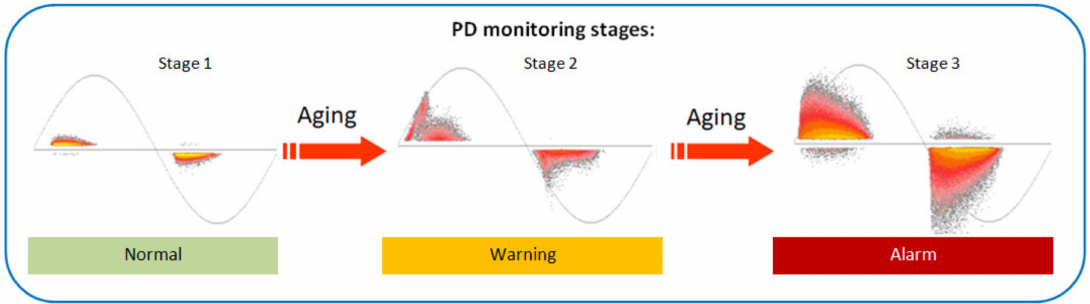
Figure 11. Example of PD monitoring sequence and distinctive patterns reflecting stages. of electrical insulation condition.